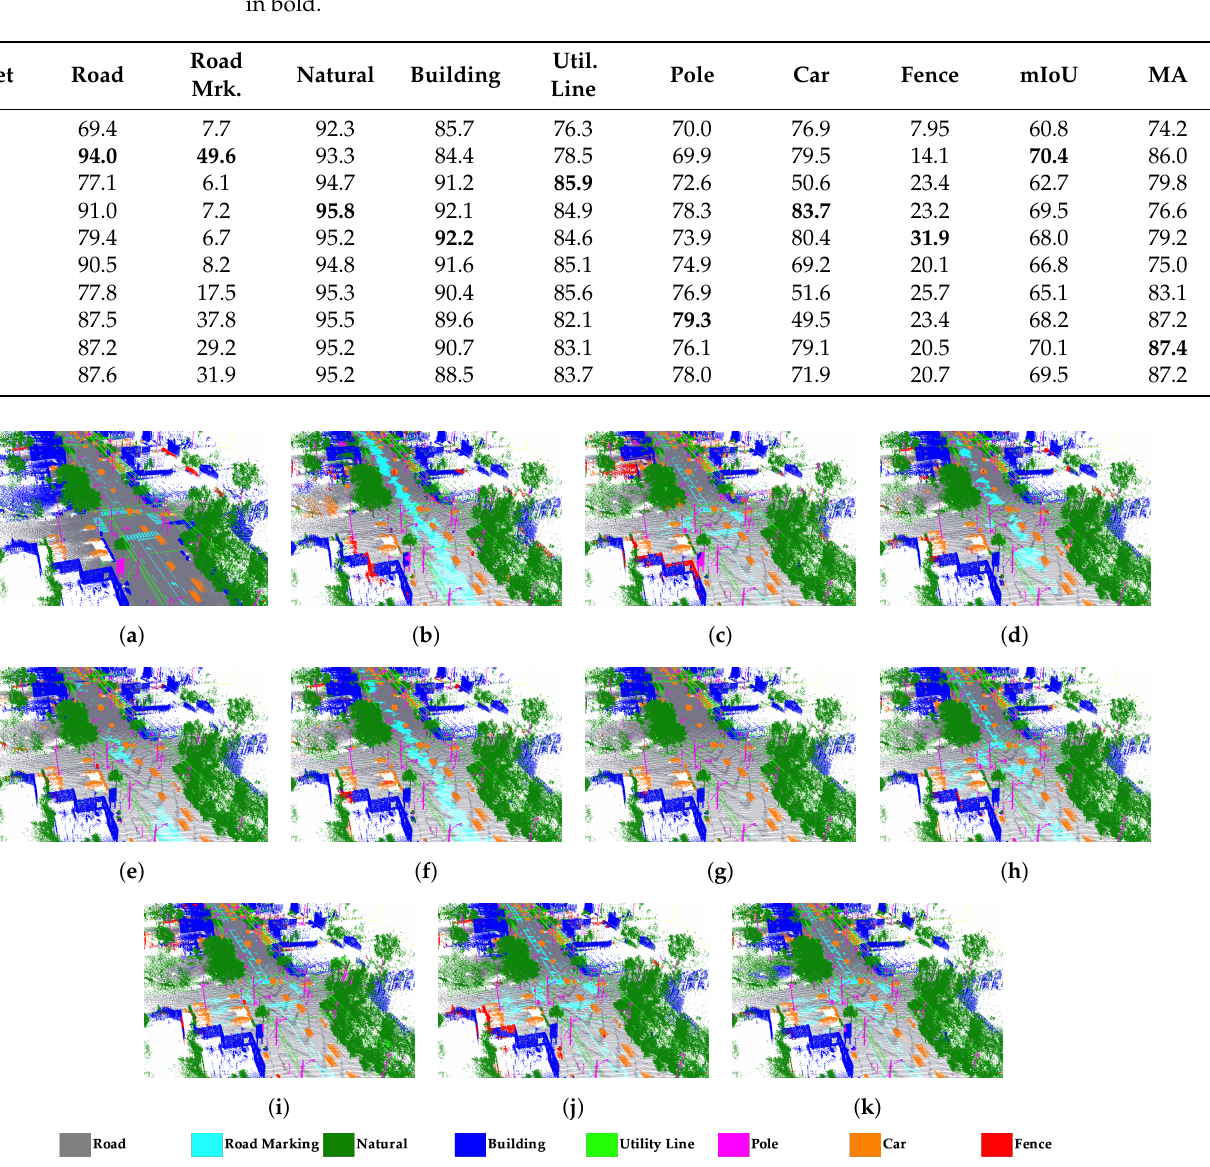
Figure 5. Qualitative results of the methods for Toronto3D with RandLA-Net. ( a ) Ground